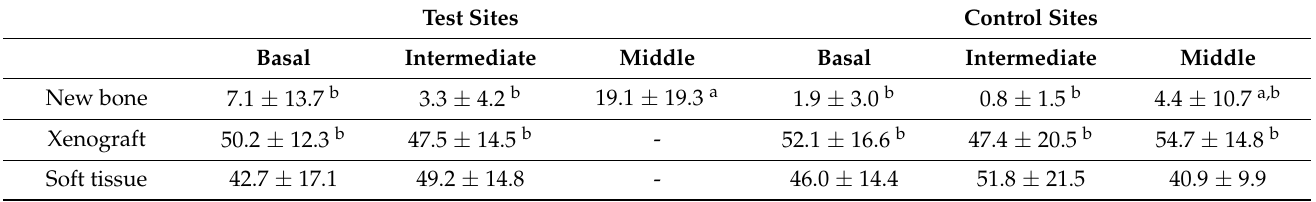
Table 3. Linear measurements. Tissues in contact with the sinus mucosa after 8 weeks of healing in the various regions evaluated. Mean values ± standard deviation in percentages. Test sites with the inward